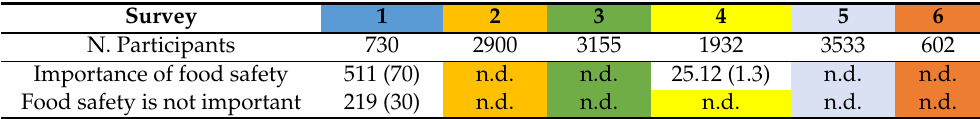
Table 11. Food safety, absolute value (N.) and (%) on the total.